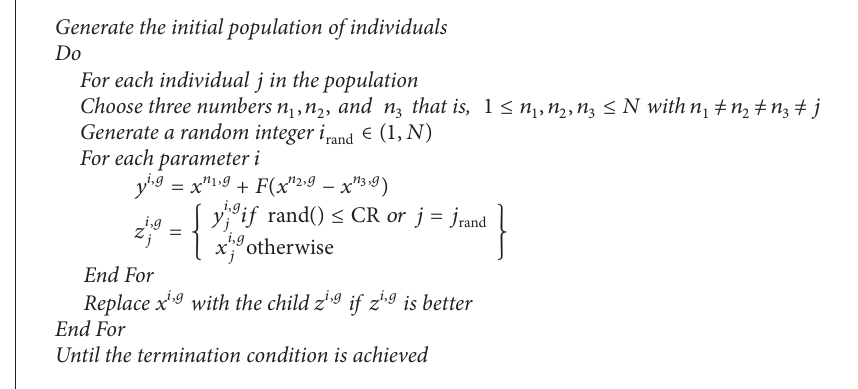
Pseudocode 1: The pseudocode of the differential evolution